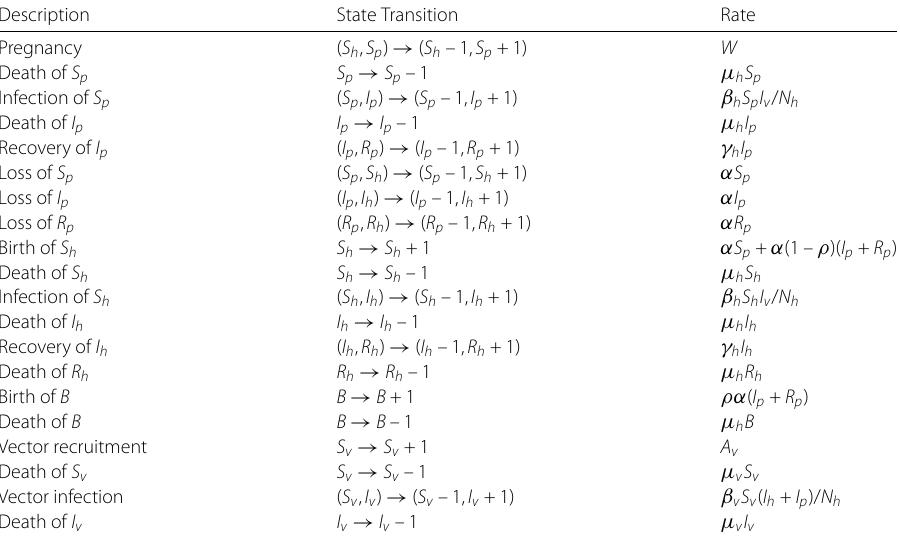
Table 2 State transitions and rates describing the CTMC Zika